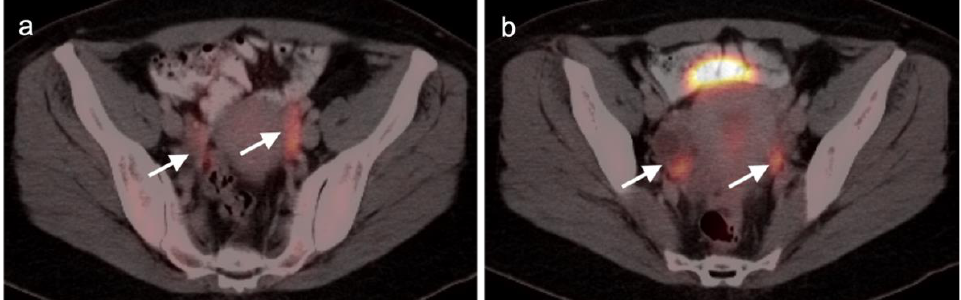
Figure 4. Physiologic [ 18 F]F-fluoro-2-deoxy-d-glucose (FDG) uptake in fallopian tubes. ( a , b ) Axial FDG-CT images of the pelvis show increased metabolic activity in the fallopian tubes (white arrows). This typically occurs during the mid-cycle and during ovulation and can be unilateral or bilateral.